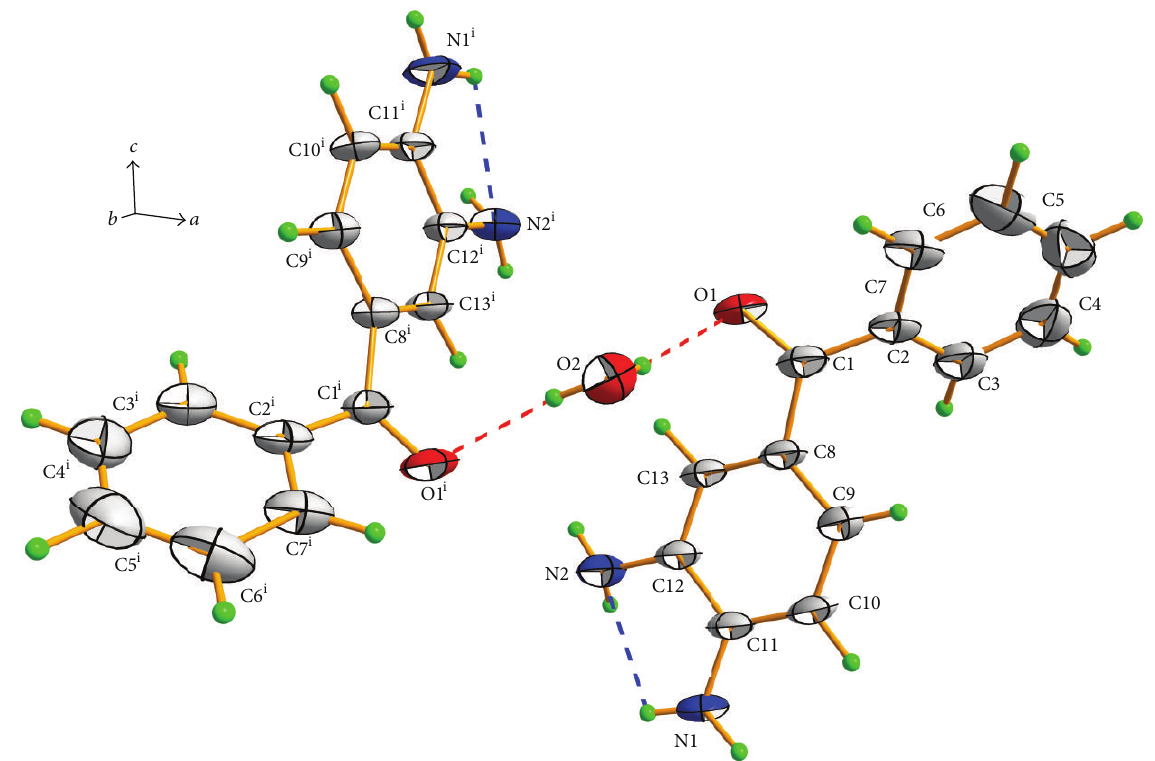
Figure 1: The molecular structure of the title compound, showing the atom numbering scheme. Displacement ellipsoids are drawn at the 50% probability level, and H atoms are shown as small spheres of arbitrary radii. Symmetry code: (i) − x , y , − z .